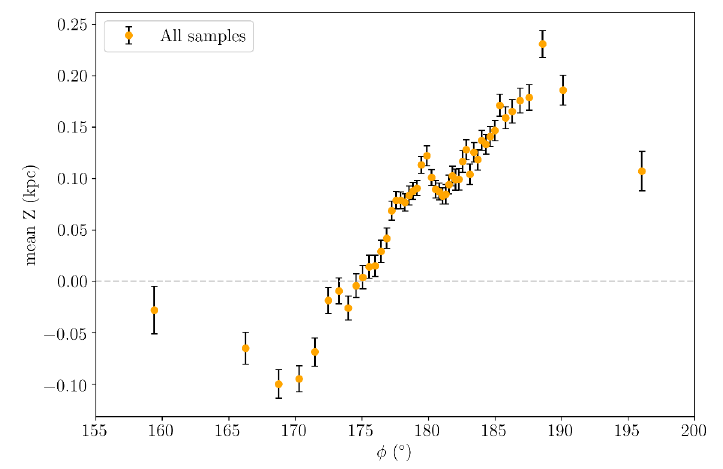
Figure 2. Mean Z as a function of φ for all samples. Each data point is consisted of 500 stars, with no overlapping. The gray dashed line is the position of galactic